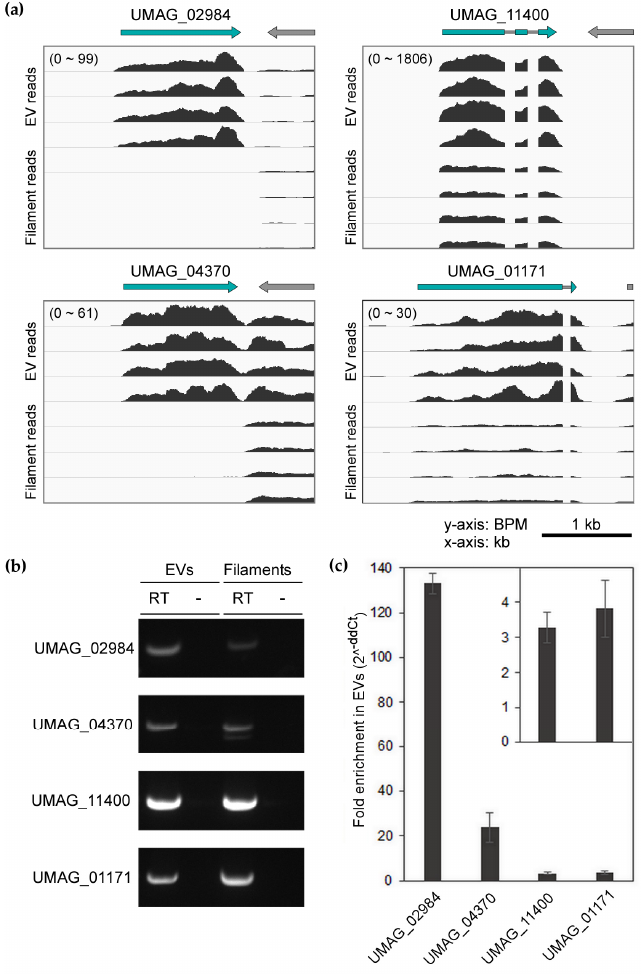
Figure 4. Presence of full-length mRNAs enriched within EVs. ( a ) RNA-seq read coverage of selected infection-relevant, EV-associated mRNA candidates in four biological replicates each of EV and filament samples. Y -axis shows normalised coverage in bases per million (bpm) and the range is indicated in brackets. X -axis is length in kb (scale bar = 1 kb). ( b ) Confirmation of full-length mRNA candidates by RT-PCR. Primers to yield amplicons covering ≥ 90% of transcript coding re- gion length were used. RT indicates that the reverse-transcribed first-strand cDNA was used as a template for PCR and “-“ sign indicates a -RT negative control. ( c ) Confirmation of relative transcript enrichment in EVs compared to filaments by RT-qPCR. Fold relative enrichment within EVs calcu- lated as 2^- ddCt . Inset shows fold enrichment of UMAG_11400 and UMAG_01171 with an adjusted y -axis.